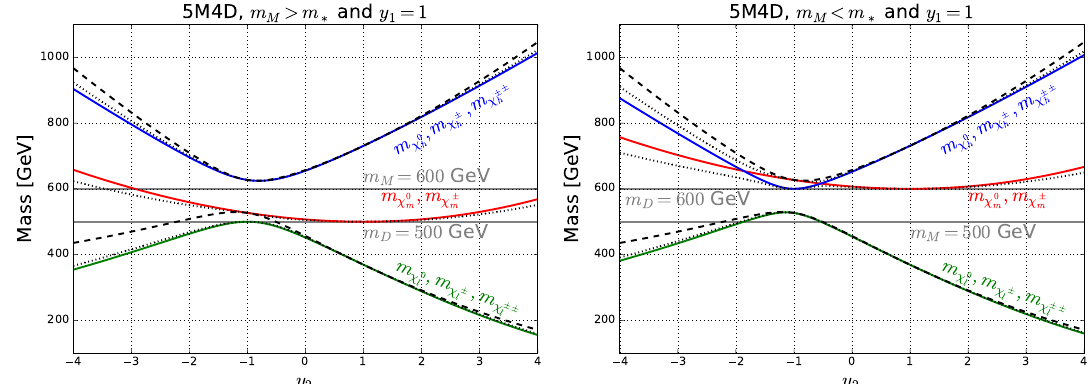
Figure 5. Mass spectra in the 5 M 4 D system for y 1 = 1 as a function of y 2 for m M & m (cid:3) (left panel) and m M . m (cid:3) (right panel). Masses of neutral states are depicted with continuous colored lines, for the singly charged states with black dotted lines and for the doubly charged states with black dashed